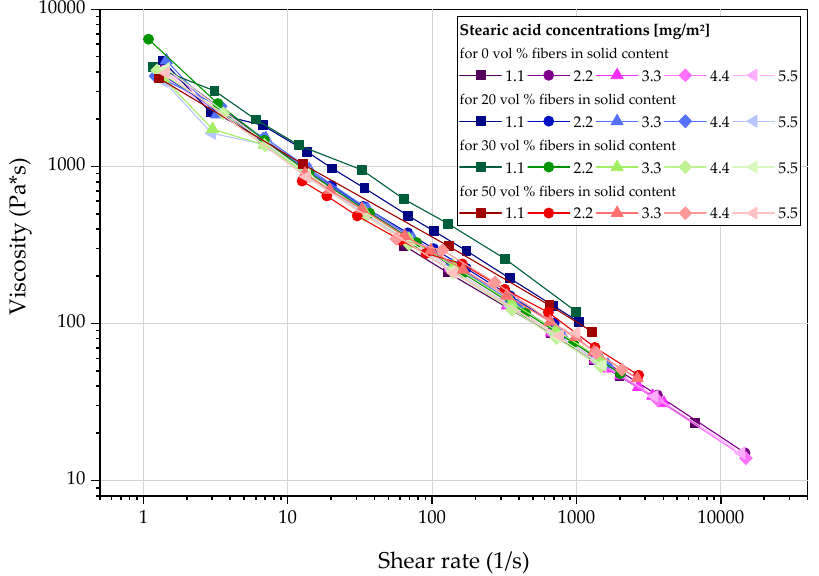
Figure 6. Viscosity results of all feedstock variations in terms of stearic acid